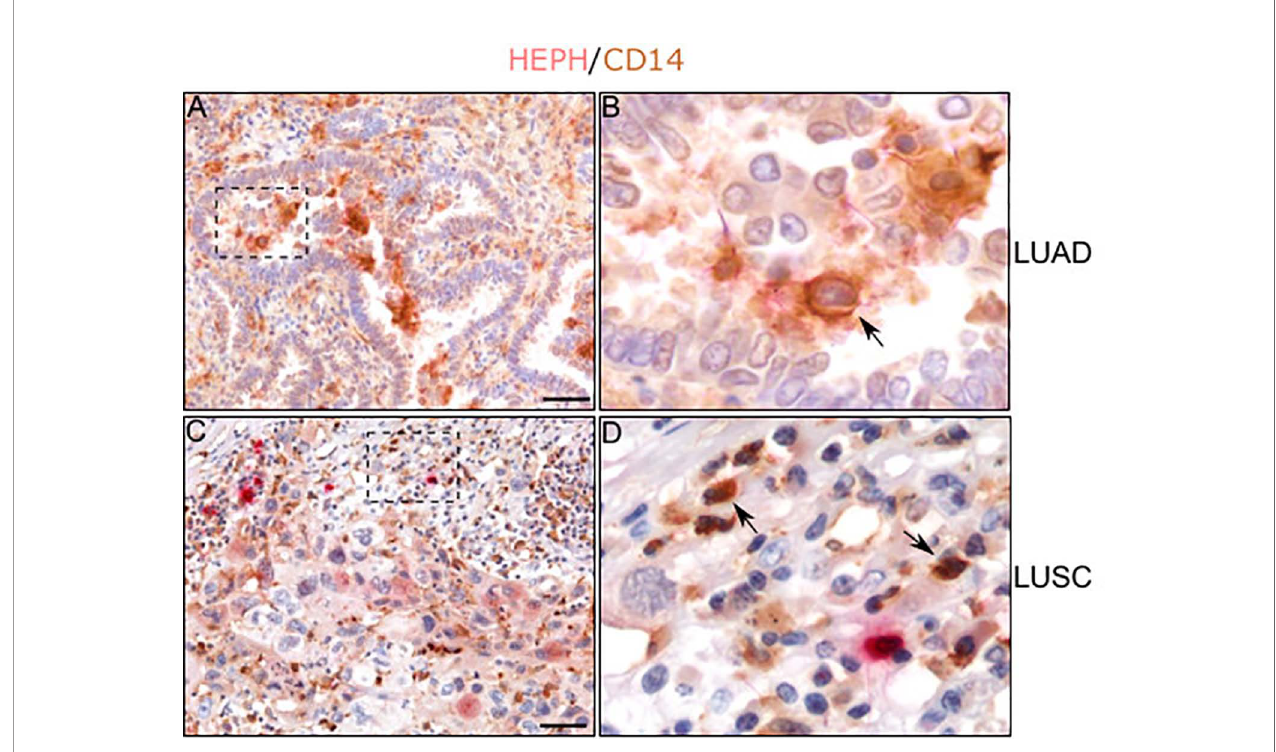
FIGURE 7 | HEPH distribution in tumor-associated macrophages. Representative microphotographs relative to HEPH expression in monocytes/macrophages recognized by CD14 immunoreactivity in LUAD (A, B) and LUSC (C, D) . Black arrows indicate HEPH/CD14 colocalization. Polymer detection system with AEC (red) chromogen for HEPH and DAB (3,3 ′ -Diaminobenzidine) chromogen for CD14; scale bars, 50